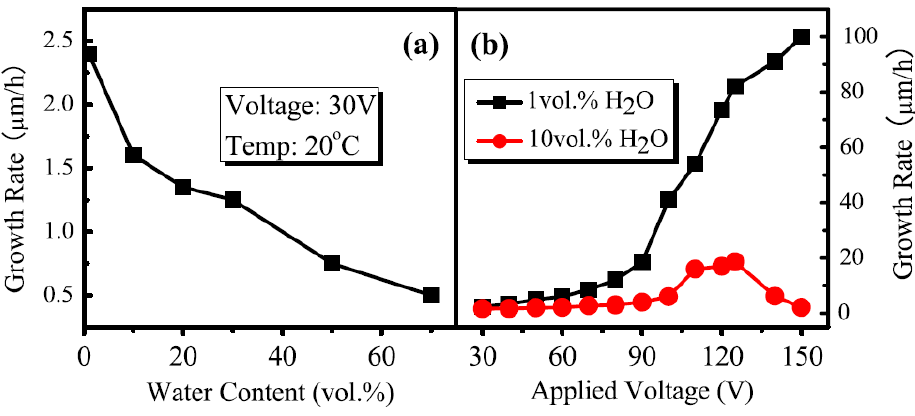
Figure 5. Effect of ( a ) water content and ( b ) anodization voltage on the nanotube growth F in ethylene glycol. Reprinted with rate using 0.09 M (0.3 wt %) NH 4